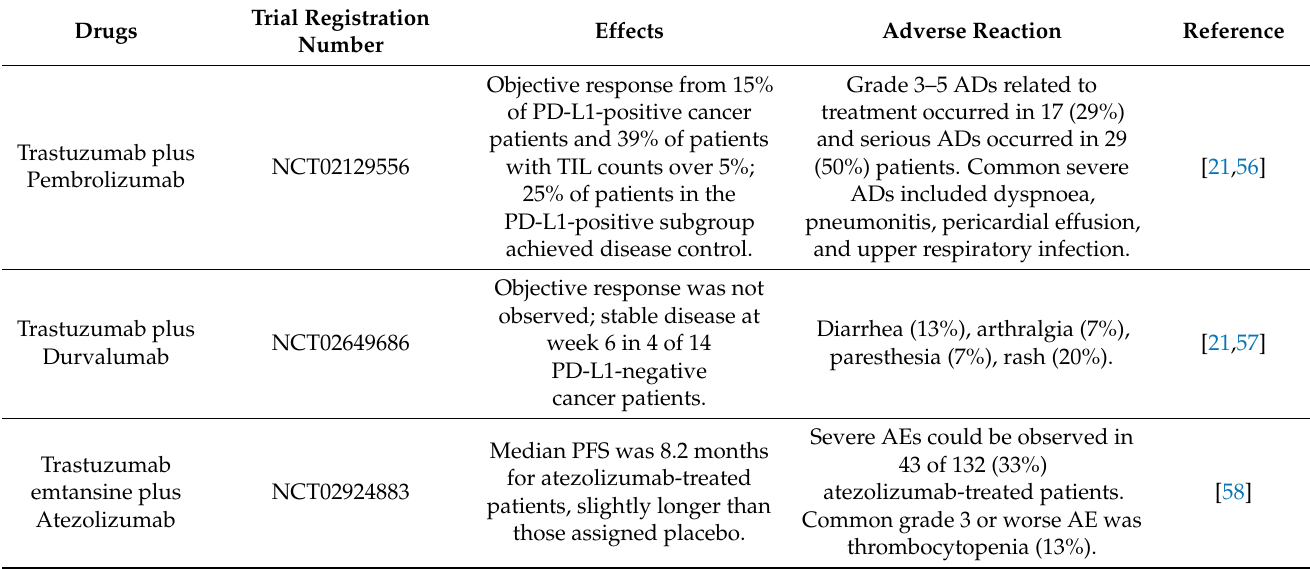
Table 2. Treatment outcome of clinical trials for PD-1/PD-L1 inhibitors combined with